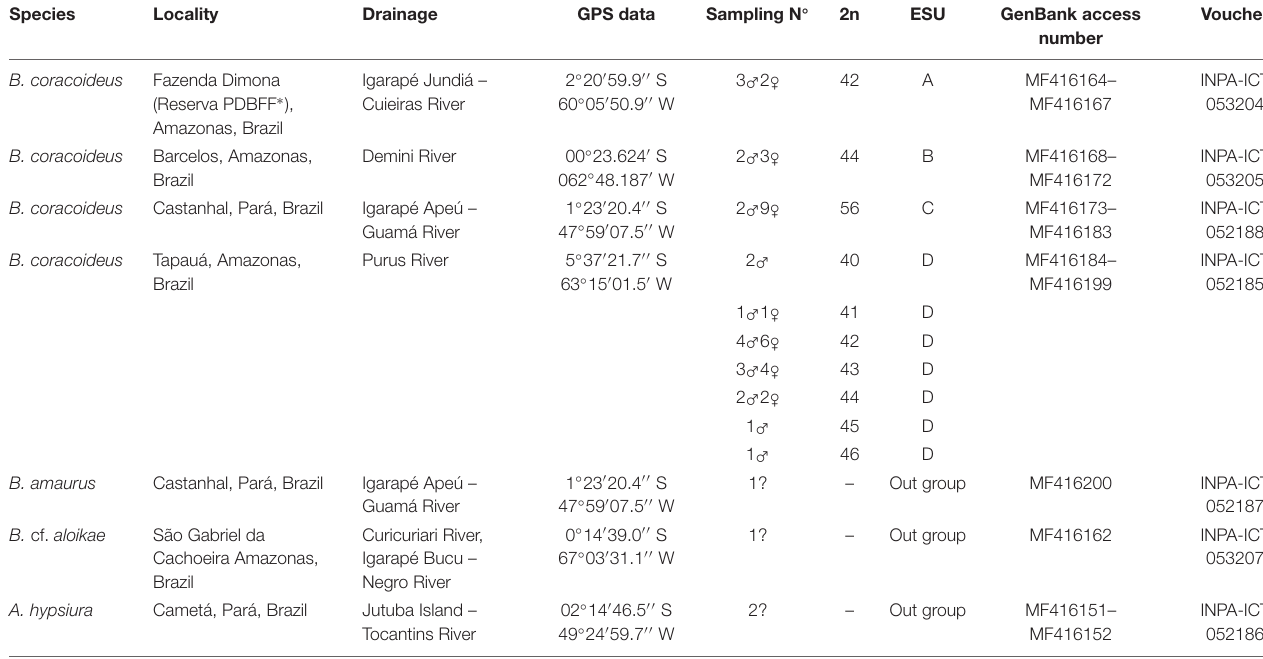
TABLE 2 | Aspredinidae specimens analyzed in the present study, with their respective collection places, number of individuals, diploid number (2n), and identification.